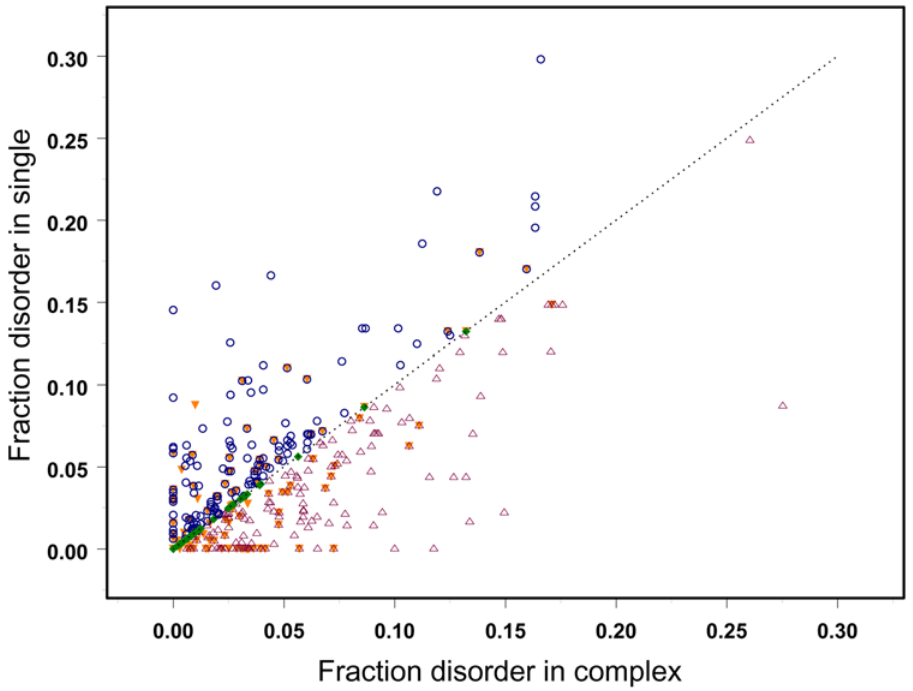
Figure 6. Fraction disorder in the alignment is plotted for monomeric and complex states of each protein averaged over families from ‘‘test588’’. Those cases with the disorder fraction in a monomer higher, lower or equal to the fraction disorder in a complex are shown with the circles, triangles and diamonds correspondingly. Entries from ‘‘test149’’ are shown as orange upside-down triangles.